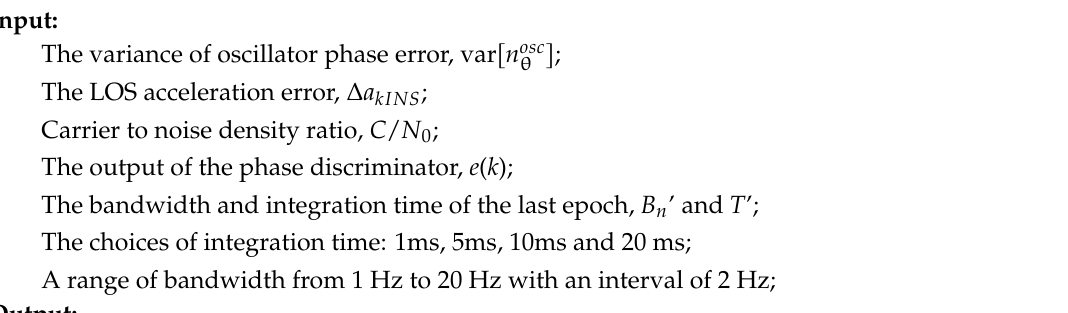
Algorithm 1. The adaptive method for choosing the optimal noise bandwidth and integration